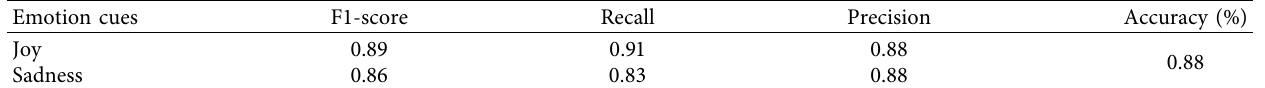
Table 3: Proposed BILSTM model performance evaluation results.